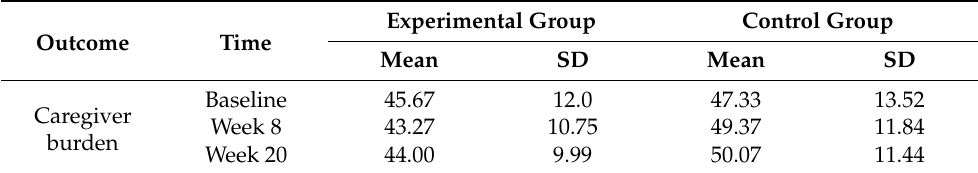
Table 3. Mean and standard deviation of caregiver burden score. ( n =